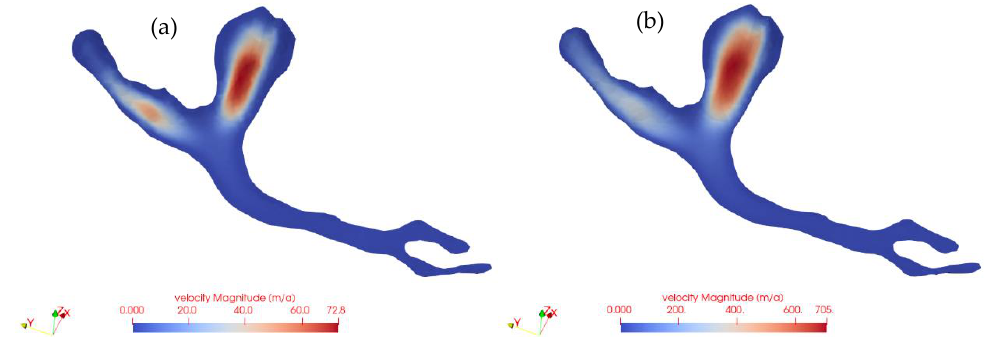
Figure 7. Simulated glacial ice flow velocities using Elmer/Ice with parameters in Table 3. ( a ) Left pane shows the scenario with mean ice thickness of 28 m, which has a maximum ice flow velocity of 72.8 m/a; ( b ) Right pane shows the scenario with mean ice thickness of 100 m, which has a maximum ice flow velocity of 705 m/a.